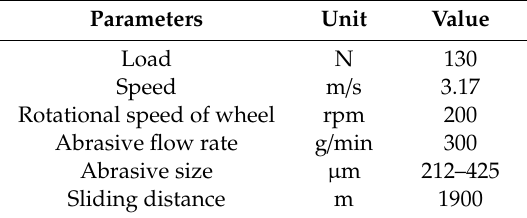
Table 5. Parameters used for three-body abrasion wear test (DSRW).